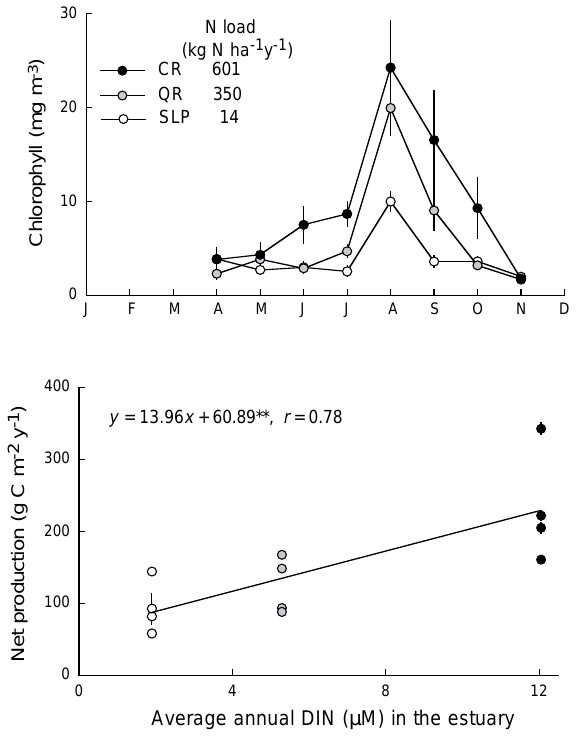
F IG . 5. – Chlorophyll concentration in three estuaries of the Waquoit Bay estuarine system across the year (top). Annual phyto- plankton production for the three estuaries of the top panel, plotted vs. the annual nitrogen load received from the watersheds (bottom). Adapted from Foreman et al. (submitted).